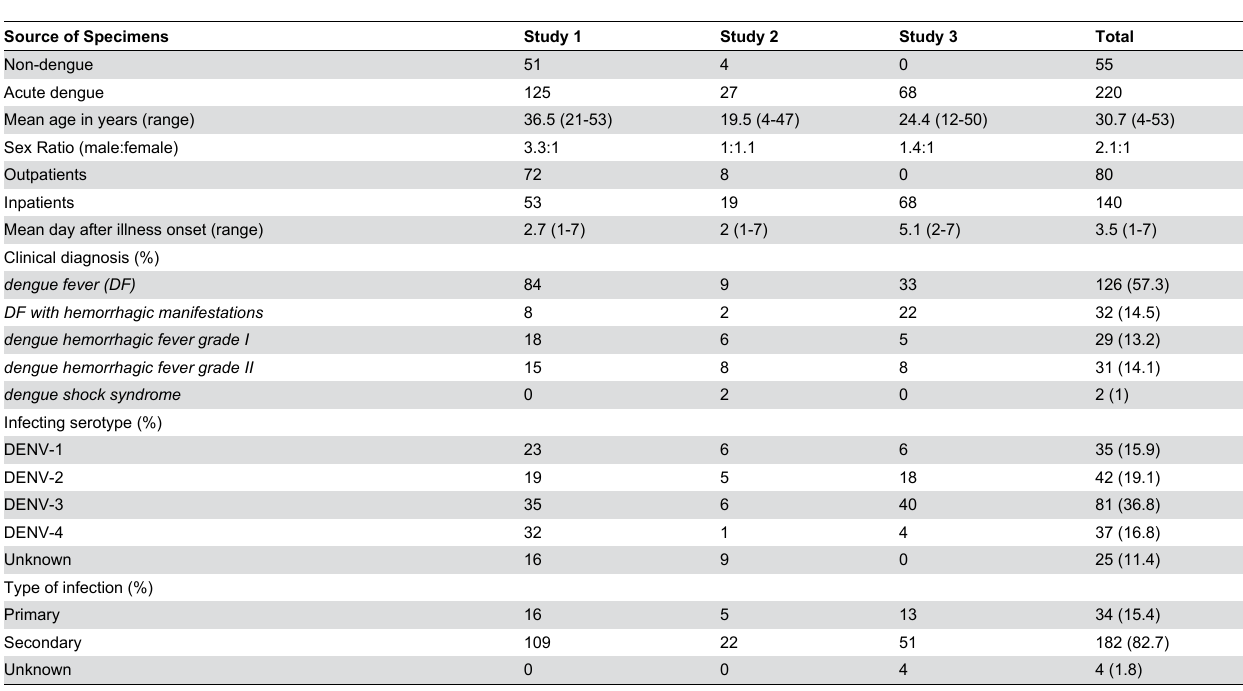
Table 1. Specimen characteristics.